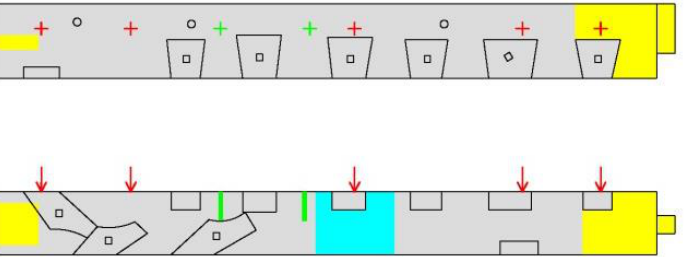
Figure 5. A scheme of the rot extent, beam (III), (yellow—replacement, blue—reduced wood density without the need for repair, grey—standard wood density without the need of repair). Arrow and + marking points measured with Resistograph.